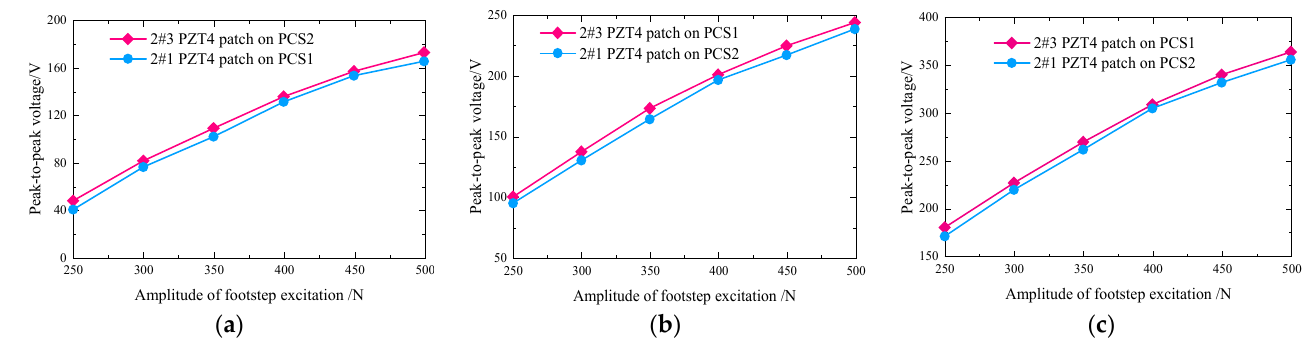
Figure 11. Comparison of peak-to-peak voltages from PZT4 patches of 2#1 on unimorph PCS1 and 2#3 on unimorph PCS2 of 2# piezoelectric brick versus the amplitude of footstep excitation ( f = 1 Hz). ( a ) L = 19.5 mm; ( b ) L = 26.5 mm; ( c ) L = 33.5 mm.